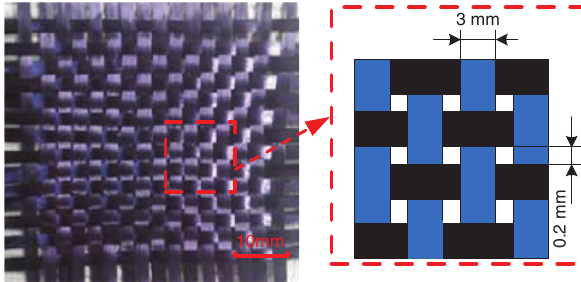
Figure 1: Photograph of the adopted carbon fabric cloth with geo- metrical